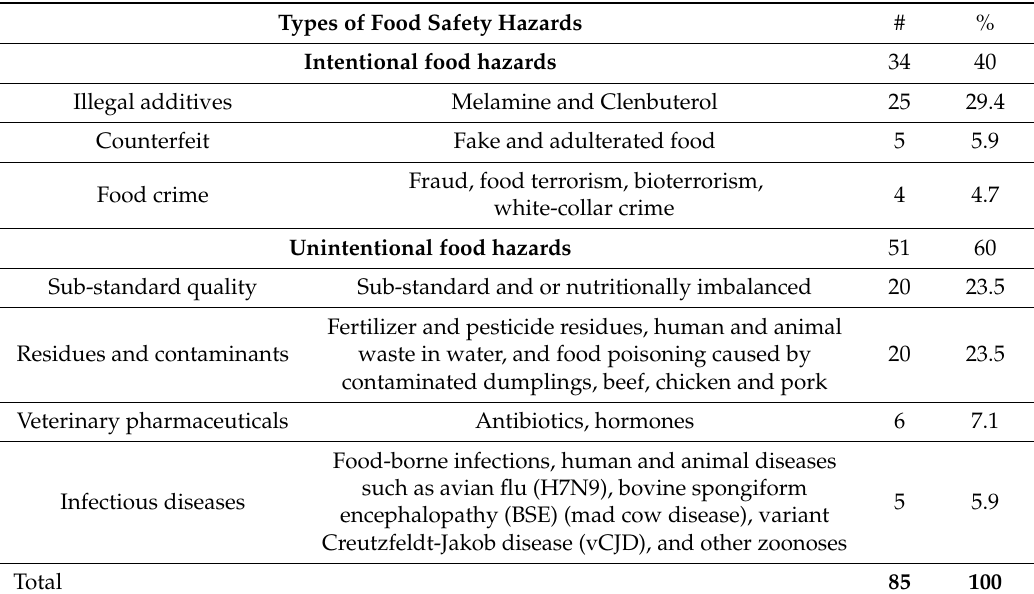
Table 4. Intentional and unintentional food safety